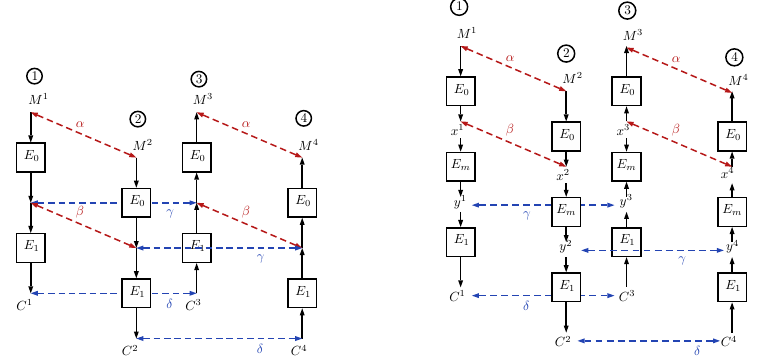
Figure 1: Configuration of the basic boomerang attack (left) and of the sandwich attack (right). Circled numbers correspond to a numbering that helps referencing states in the following